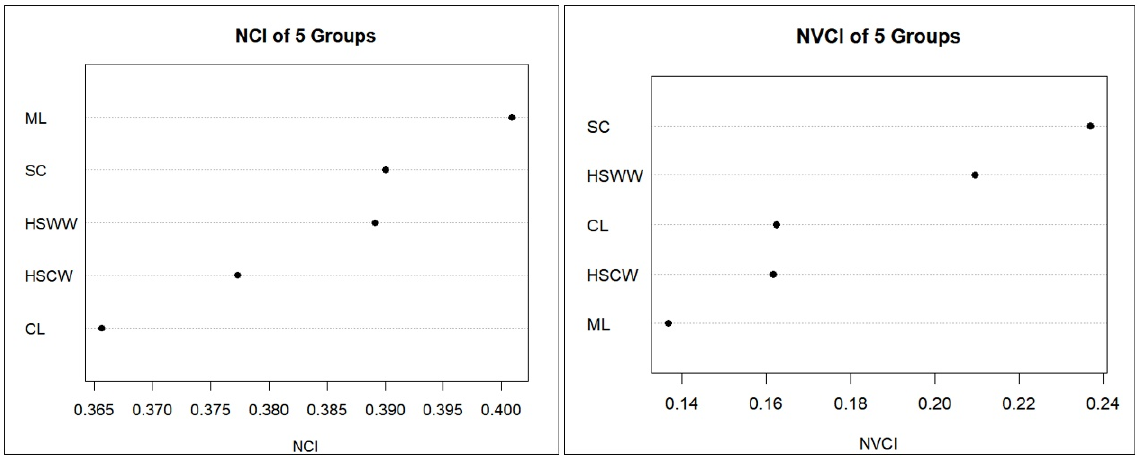
Figure 9. Ranking of mean NCI and NVCI values of the 5 zones.